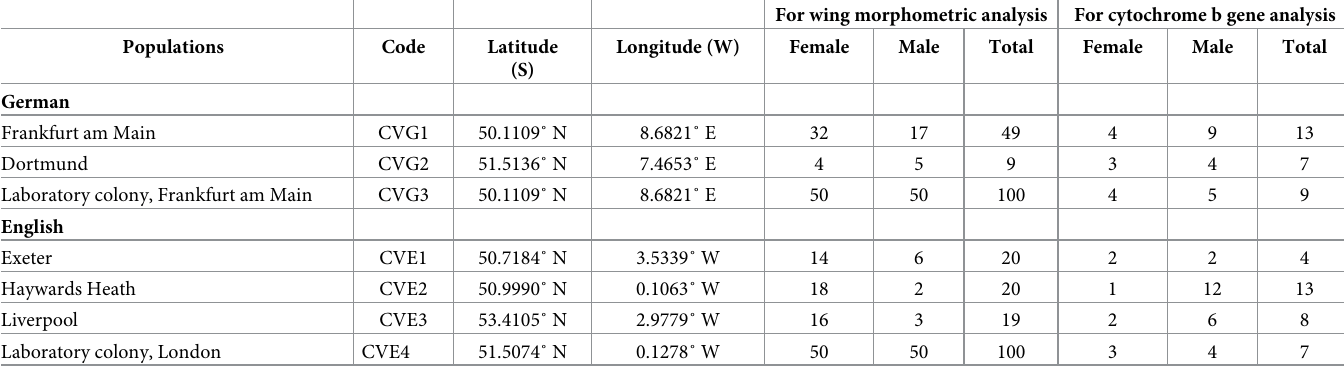
Wing morphometrics Wing preparation. Fine forceps were used to remove the right wing of each fly. Each wing was placed on a drop of Euparal (Waldeck GmbH & Co. KG, Muenster Germany) on a glass slide, then a thin layer of Euparal was added to the wing and a cover slip was placed on top. After drying at room temperature for 24 h, each wing was photographed using a digital camera (AxioCam ICc1) attached to a stereomicroscope (Olympus SZ61) at 1 × magnification. Tps files of each wing were created using TpsUtil V.1.70 software [30] to minimize bias in digi- tizing landmark locations. The coordinates of 19 landmarks were digitized using TpsDig2 V.2.26 software [31]. They were located at the base of the wing, the intersection of wing veins with each other, the intersections of wing veins with the wing margin, and the intersection of the cross vein with the major vein branch point (Fig 2). Digitization was undertaken twice in order to reduce the measurement error [32]. Wing morphometrics. The established tps files contained digitized coordinates of 19 homologous landmarks from all wings and were subjected to the MorphoJ software [33] for alignment using Procrustes Fit function. This alignment removed scale, position and rotation. Table 1. Geographic locations of the sampled areas and number of specimens for wing morphometric and for cytochrome b gene analyses. For wing morphometric analysis For cytochrome b gene analysis